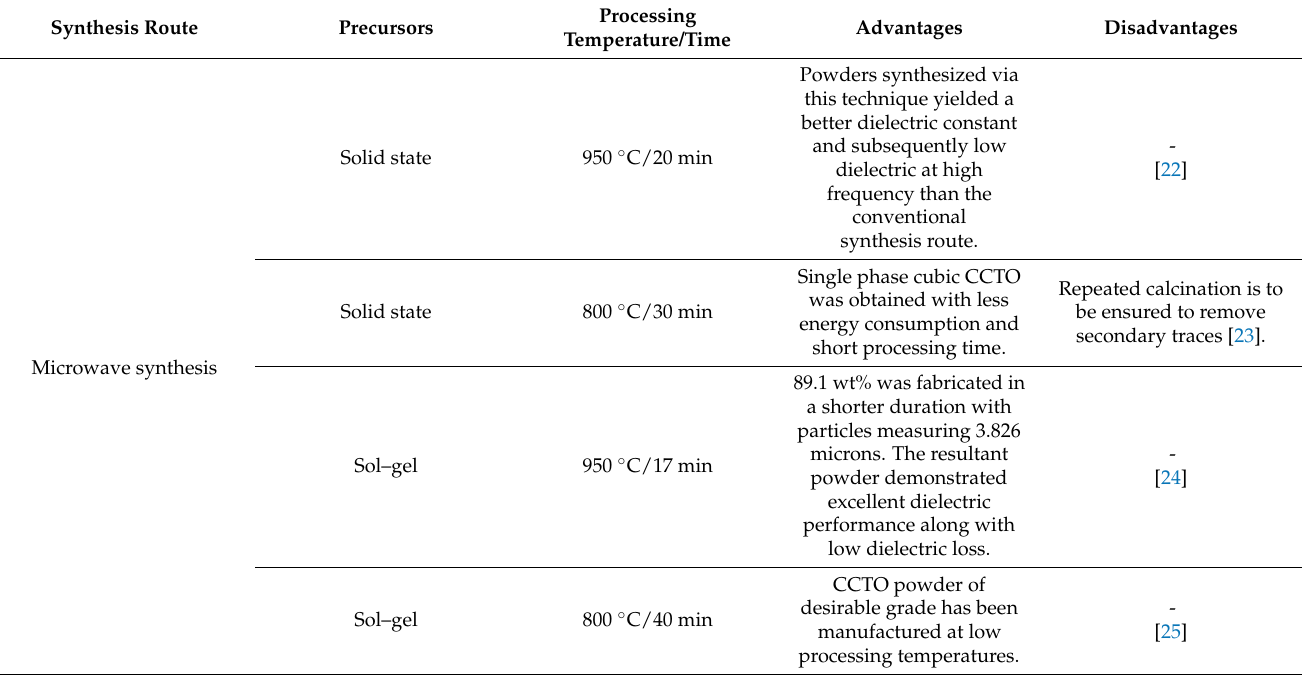
Figure 4. TEM images of ( a – d ) selected area electron diffraction (SAED) pattern of CCTO [36]. Table 1. Process, procedures, advantages, and drawbacks of different synthesis routes .